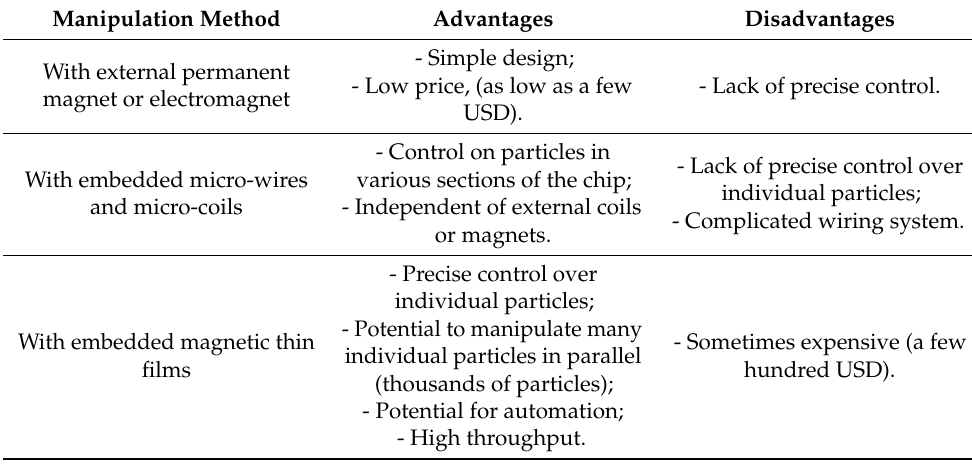
Figure 11. ( a – h ) Magnetic energy distribution simulation results for the magnetic thin film pattern exposed to a 3D rotating magnetic field with a cone angle of 45 degrees are shown. The black arrows stand for the in-plane magnetic field direction in each panel. The black circle depicts the particle, the trajectory of which is illustrated by the dotted line. The blue and red areas stand for the energy minimum and maximum, respectively. ( i ) The experimental trajectory of a magnetic particle transported along the magnetic track is shown with the black line. Reprinted from R. Abedini-Nassab, et al., 2021 Lab on a Chip 21, 1998–2007 [115] with permission from Royal Society of Chemistry. Table 3. Advantages and challenges of various particle manipulation